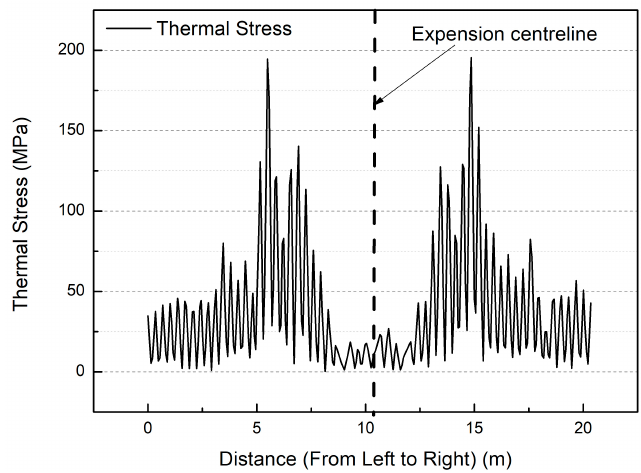
Figure 13. Thermal stress distributions along the width of the front wall at the highest tube temperature difference.